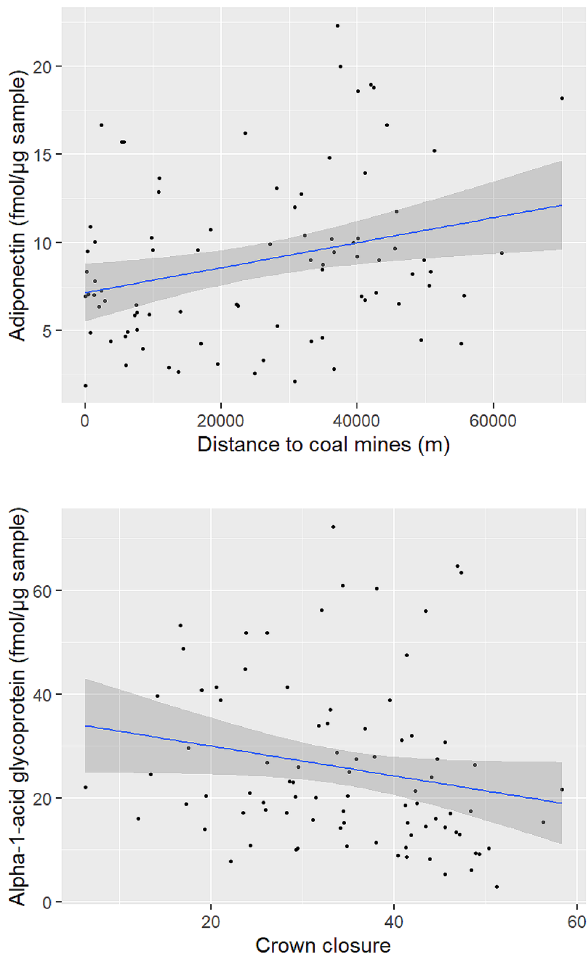
Figure 2. Estimated expression (solid blue line) of adiponectin (top panel) and alpha-1-acid glycoprotein (bottom panel) related to the distance to coal mines and crown closure, respectively. Grey shade is 95% confidence band and closed symbols are the raw data of protein expression. Figure was created using R statistical software version 4.0.3 and R studio version 1.3.1093 (https:// www.R- proje ct.